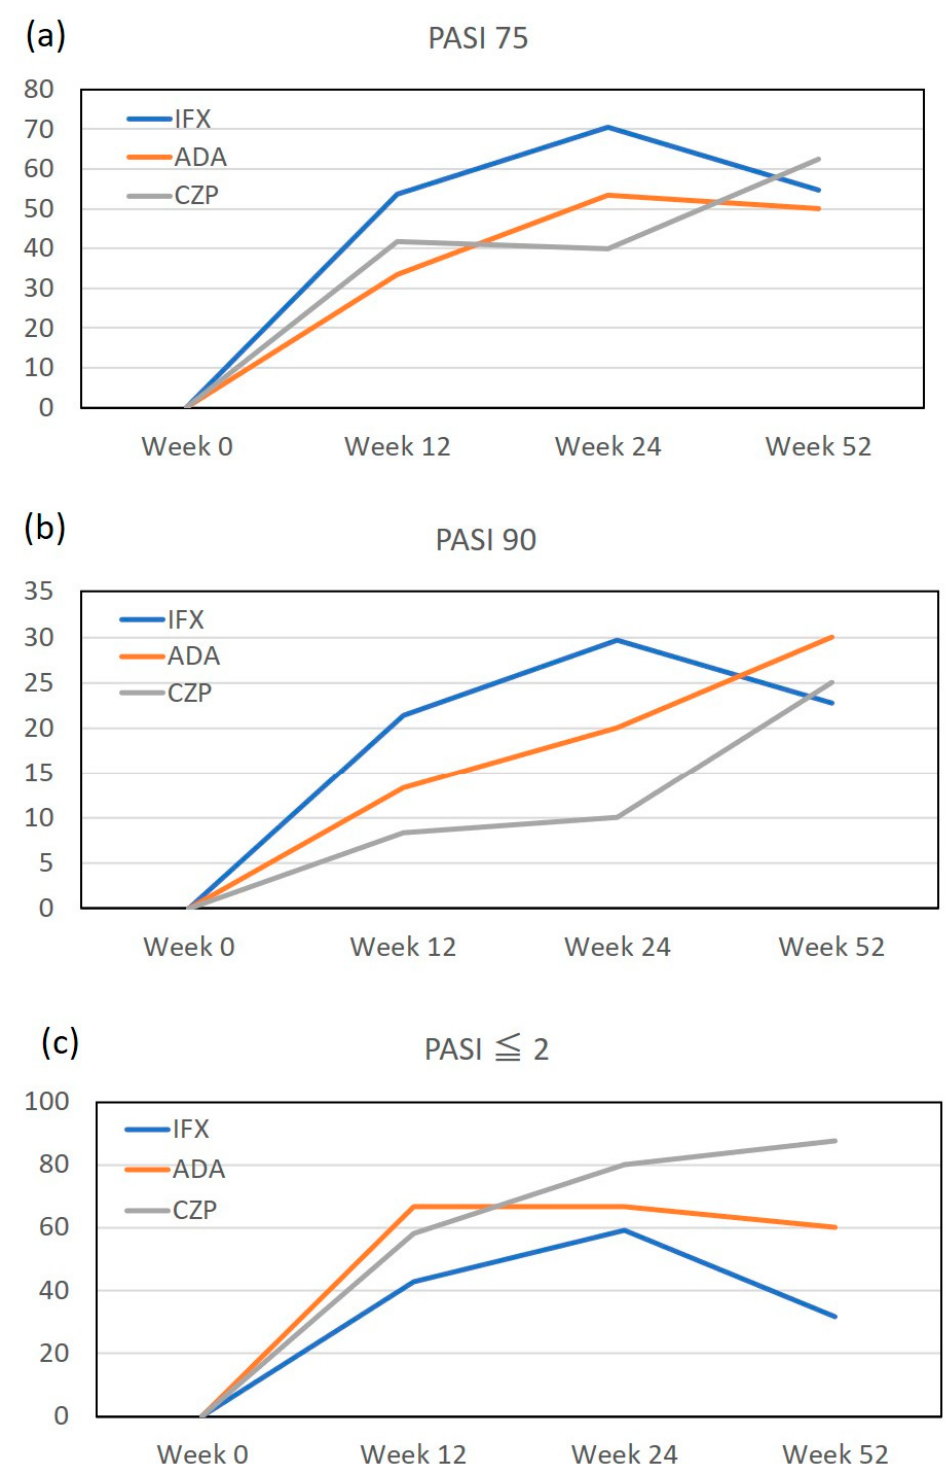
Figure 1. The achievement rates of psoriasis area and severity index (PASI) 75, 90 and absolute PASI ≤ 2 during treatment with individual TNF- α inhibitors in patients with psoriasis. PASI 75 response rate ( a ), PASI 90 response rate ( b ) and PASI ≤ 2 response rate ( c ), respectively.